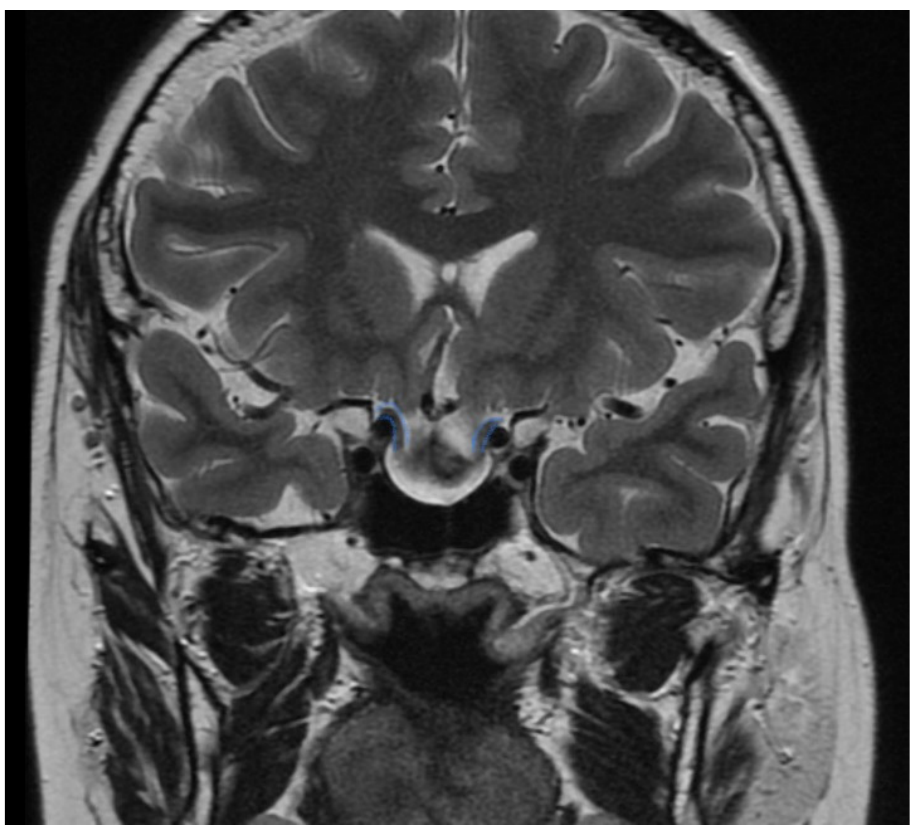
Figure 2. This T2-weighted MR-image depicts the unusual position (blue lines) of the anteriorly-inferiorly displaced optic nerves in the patient that experienced a new bitemporal hemianopia post-operatively.